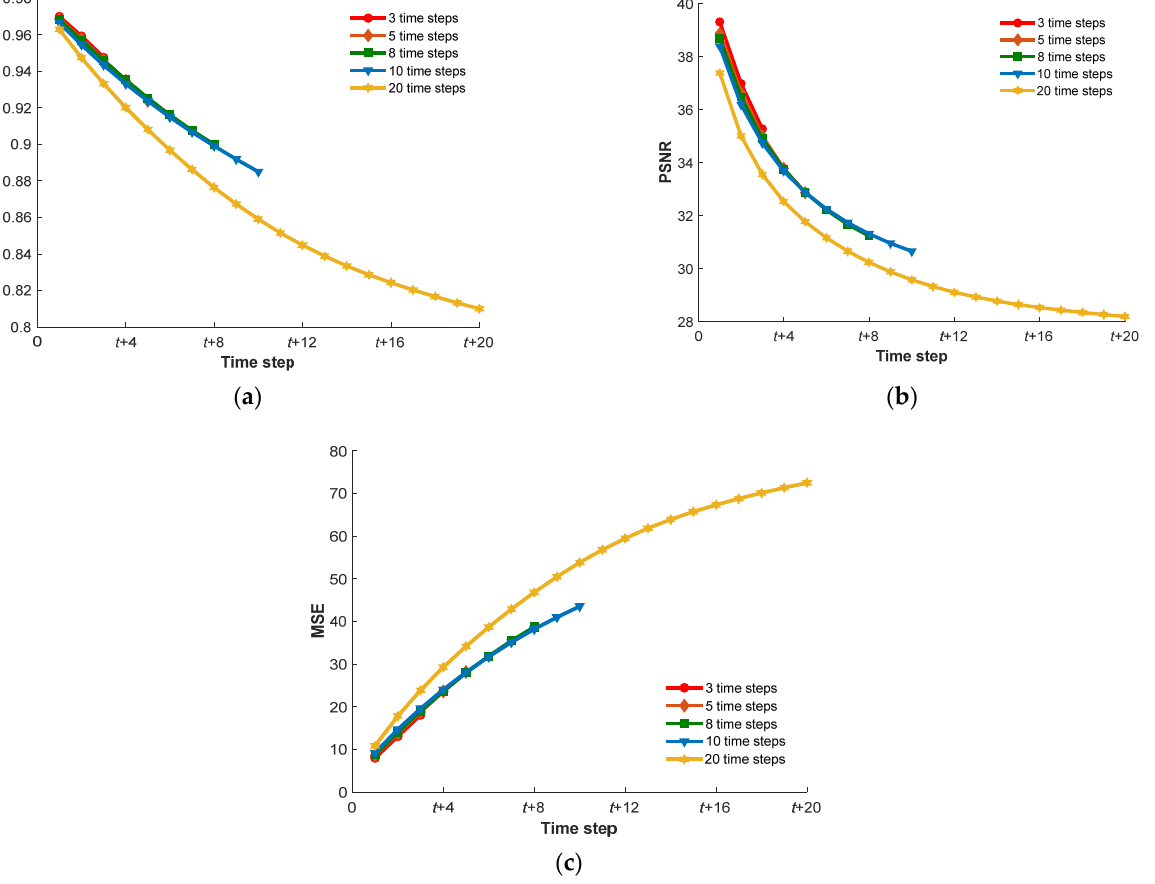
Figure 6. Average evaluation results of MSE ( a ), PSNR ( b ), and SSIM ( c ) at each time step where the number of prediction steps was set as 3, 5, 8, 10, and 20.